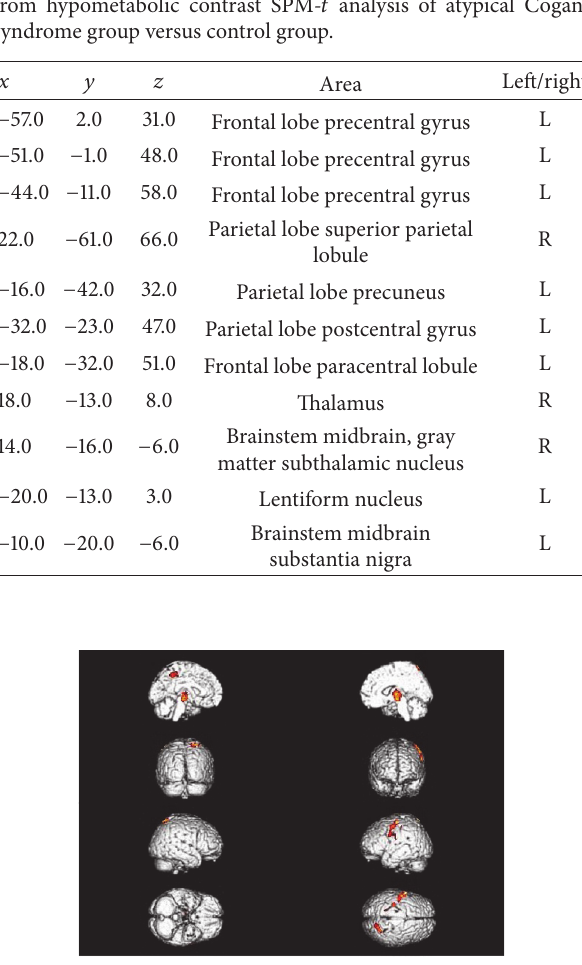
Figure 3: SPM hypometabolic maps comparing atypical CS group and the control group.